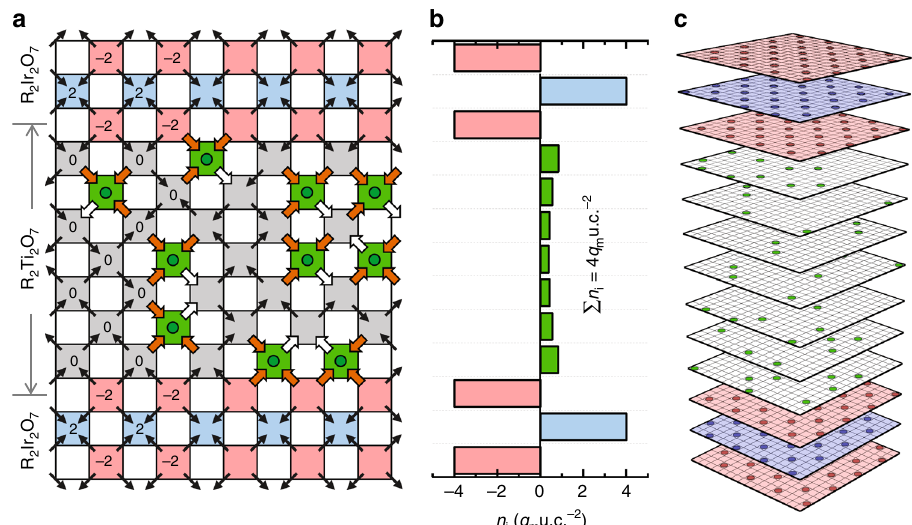
Fig. 2 Static snapshot of 2DMG. a a 2D illustration of a static snapshot of a 2DMG in a spin ice R 2 Ti 2 O 7 slab sandwiched between two antiferromagnetic R 2 Ir 2 O 7 slabs with the boundary moments terminated to be pointing toward the R 2 Ti 2 O 7 slab. The tetrahedral sites with magnetic charge Q = 0 are in gray, Q = q Q = 2 q Q = − 2 q fi le of the monopole distribution taken from the average of snapshots, and c an m in green, m in blue, and m in red. b A depth pro example of the snapshot of monopole distribution from the ground states in the Monte Carlo results of a R 2 Ir 2 O 7 /R 2 Ti 2 O 7 /R 2 Ir 2 O 7 sandwich with the nearest neighbor model and a parameter with 6 J df / J eff =